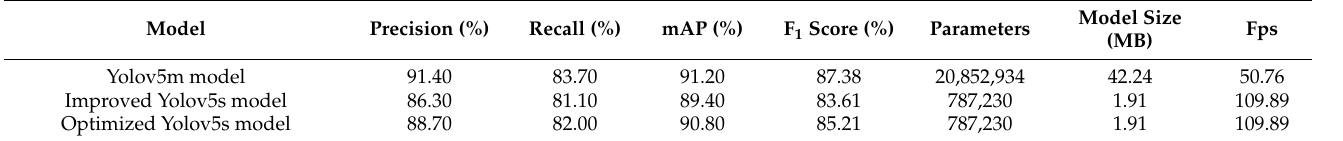
Table 4. The model performance with different